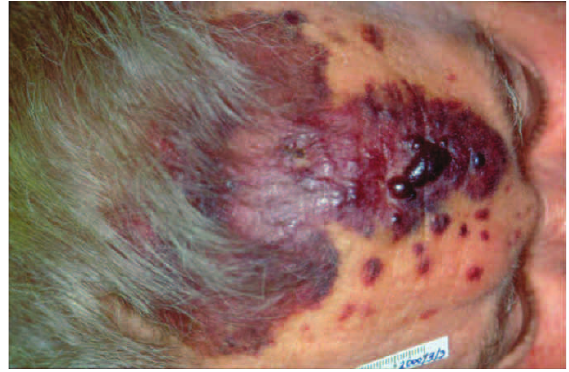
Figure 1. Cutaneous angiosarcoma of scalp: